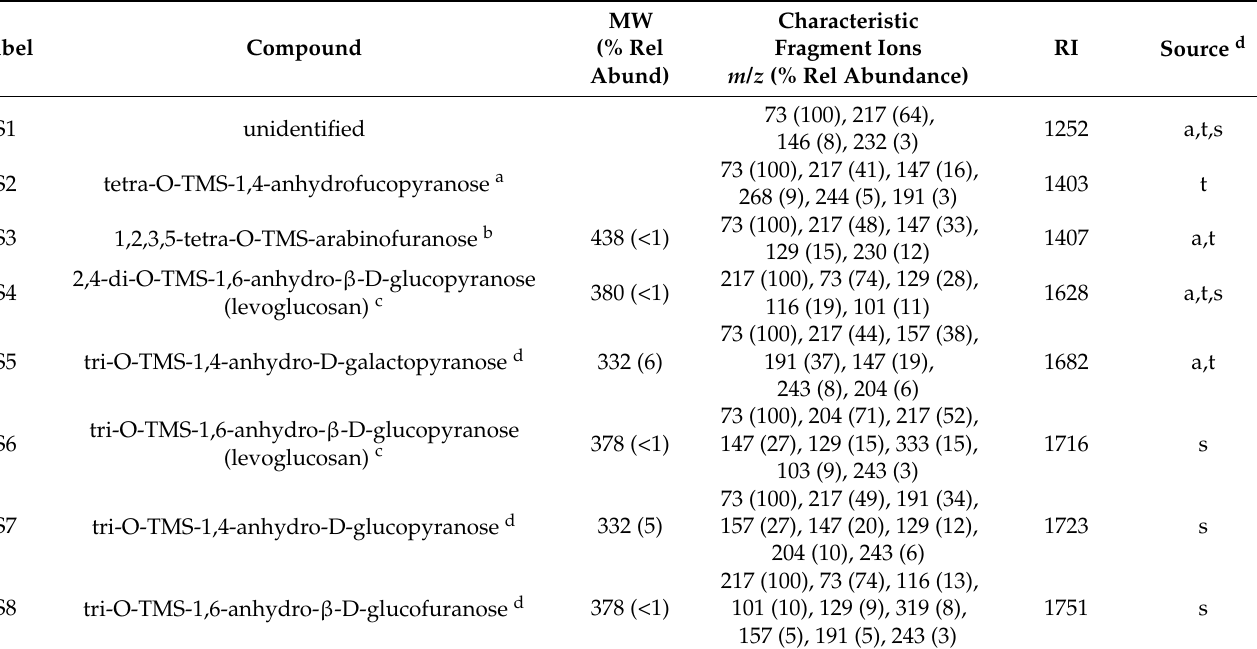
Figure 8. Extracted ion chromatograms ( m / z 217) from the HMDS Py-GC-MS analysis of hot water extracts of reference materials (starch, gum arabic, and gum tragacanth) and linen threads from pleated textiles. Labels correspond to compounds presented in Table 3. Table 3. List of compounds corresponding to the labelled peaks in Figure 8.